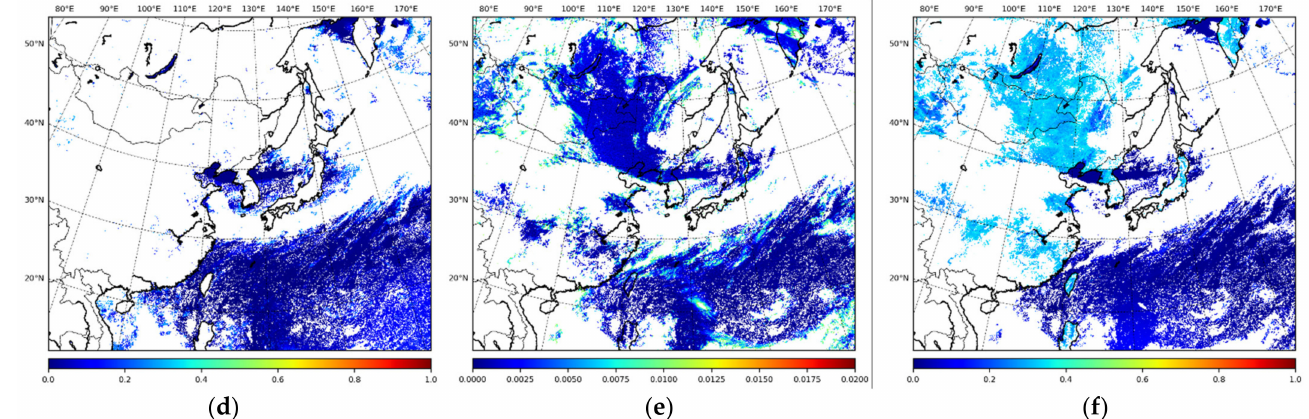
Figure 7. Results from applying the dynamic threshold. The imagery was captured on 15 June 2020 at 03:00 UTC: ( a ) the TOA reflectance of 0.8 µ m applied by filtering techniques using angular variation and minimum TOA reflectance; ( b ) the result of applying the dynamic threshold by classifying land and sea in ( a ); ( c ) the NDVI in the sea with the dynamic threshold; ( d ) the TOA reflectance of 1.6 µ m in the sea with the dynamic threshold; and ( e ) the TOA reflectance of 1.3 µ m with the dynamic threshold. Originally, an initial threshold of 0.02 is applied. Therefore, the maximum of the color bar is set to 0.02. ( f ) The result from applying the filtering methods and dynamic threshold. It is produced by applying the results of ( c – e ) to ( b